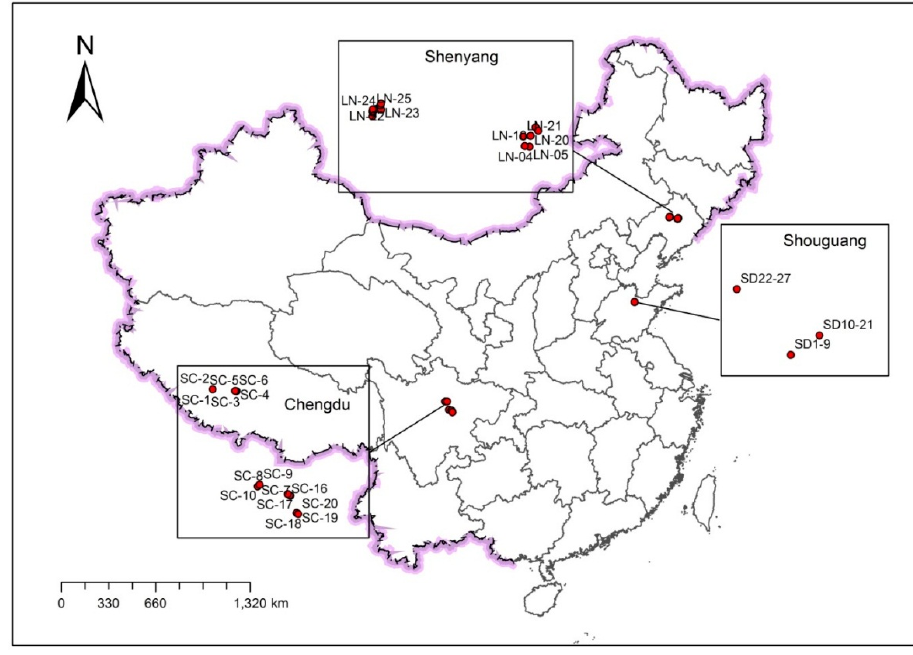
Figure 1. The sampling sites of Shenyang, Shouguang and Chengdu from the provinces of Liaoning (LN), Shandong (SD) and Sichuan (SC), respectively.